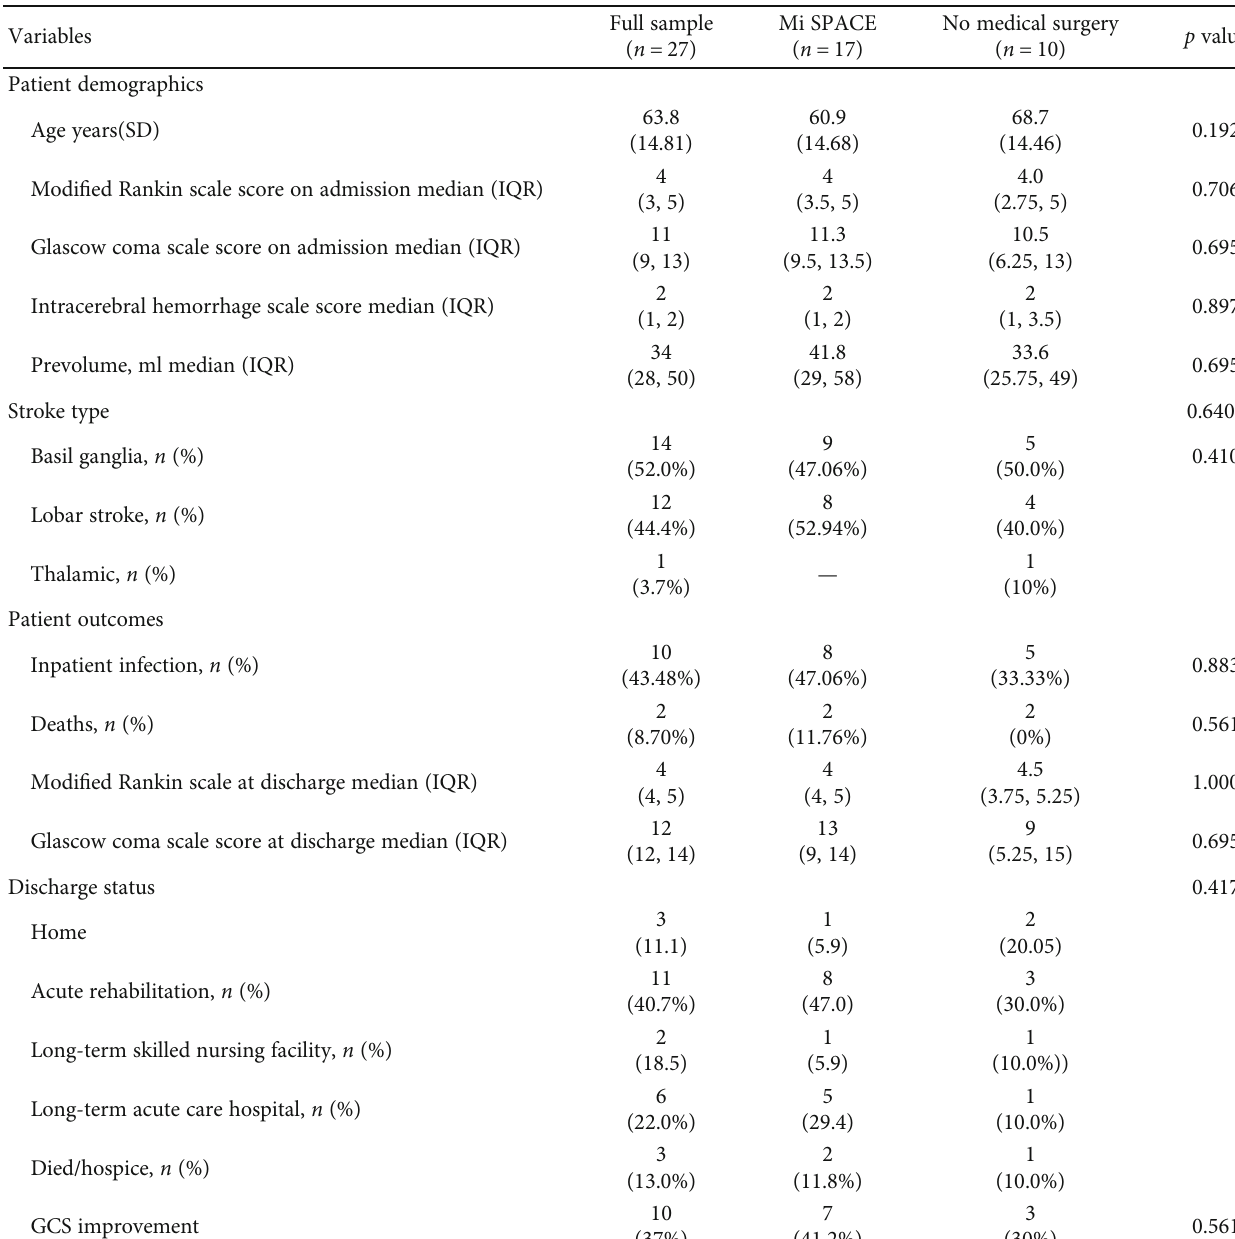
Table 5: Demographic, preclinical, and outcome data by Mi SPACE and medically managed patients without surgery.